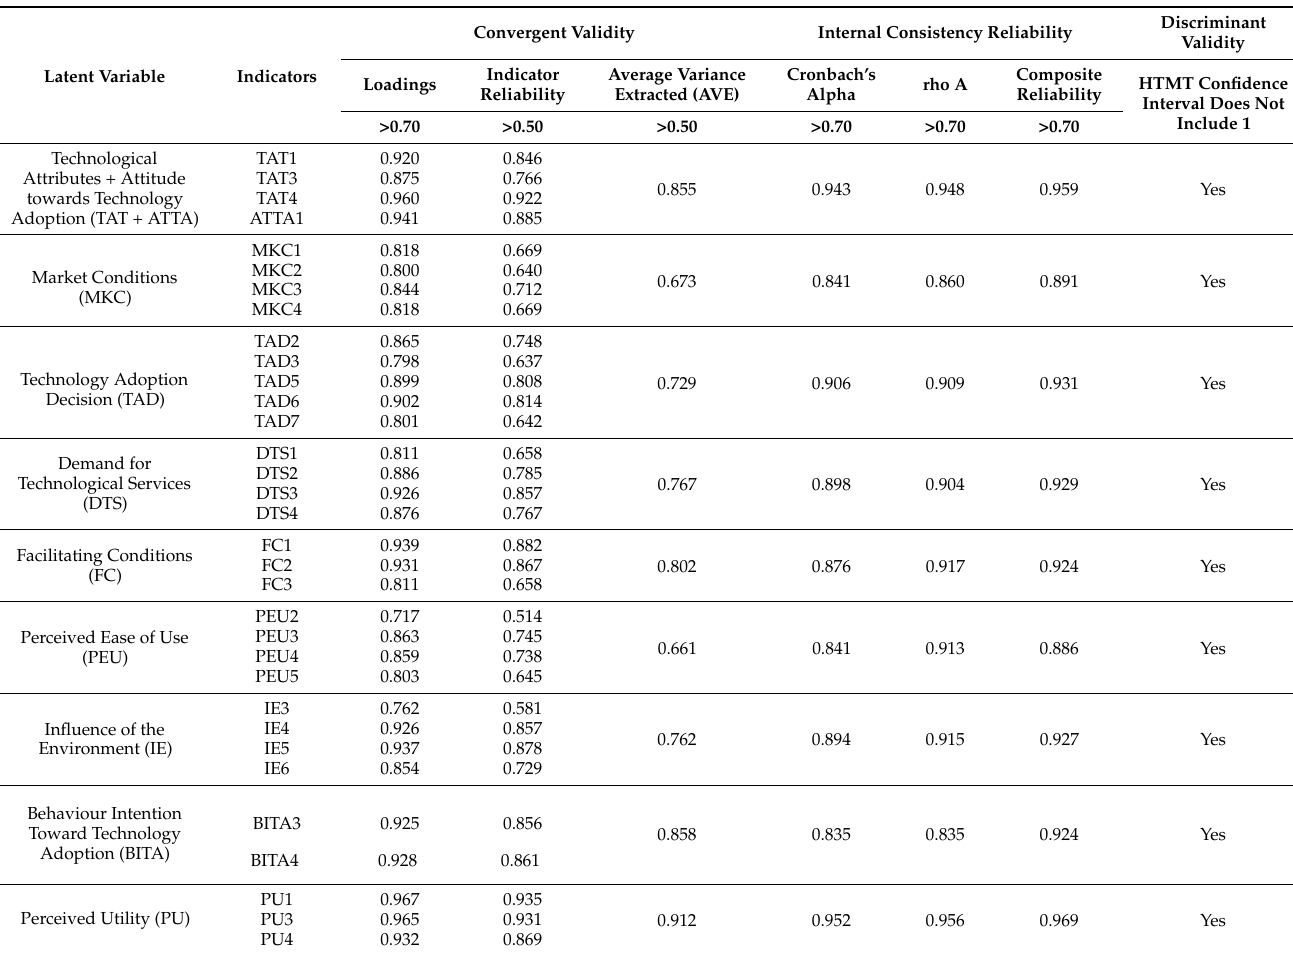
Table 2. Reliability and validity of reflective measurement models.